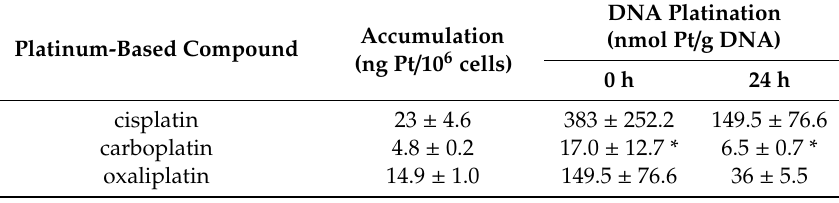
Table 2. Platinum accumulation and DNA platination in A498 cells following incubation for 2 h with 50 µ M of the platinum-based compound. The mean values are shown from three independent determinations ± standard deviation (* two independent determinations). The result of cisplatin accumulation is taken from